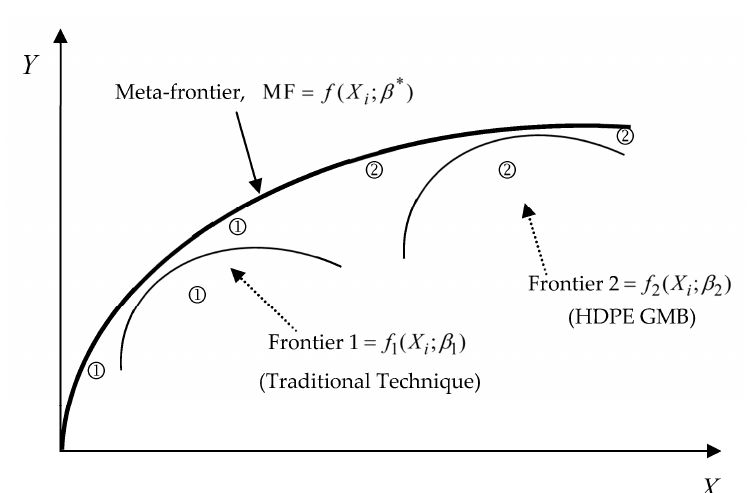
Figure 3. Meta-frontier model. Source: Modified from Battese et al. (2004)